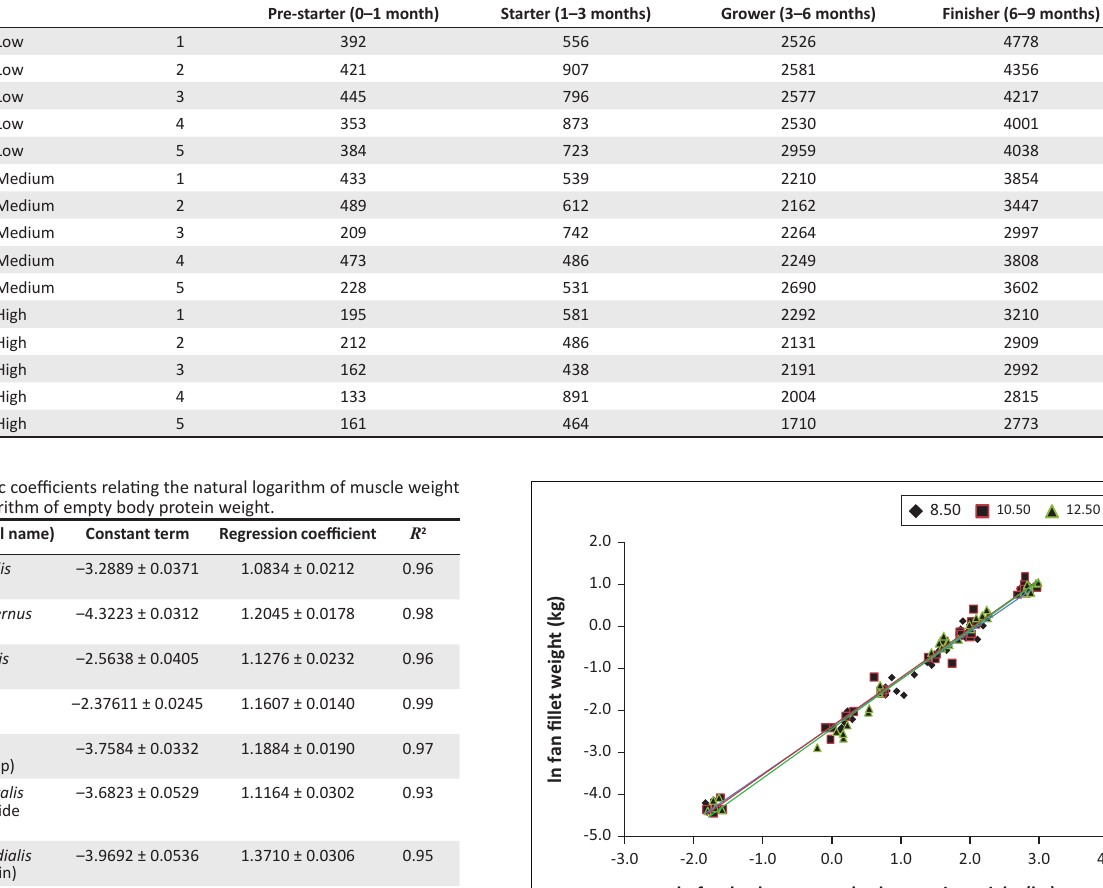
TABLE 2: The average feed intake of the birds during the pre-starter, starter, grower and finisher phases at various energy and protein levels in the formulated diets. Feeding regime